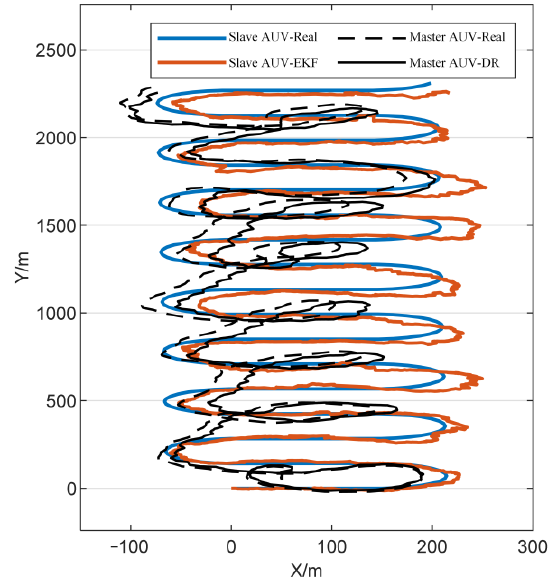
Figure 17. Paths of the master and slave AUVs based on EKF.